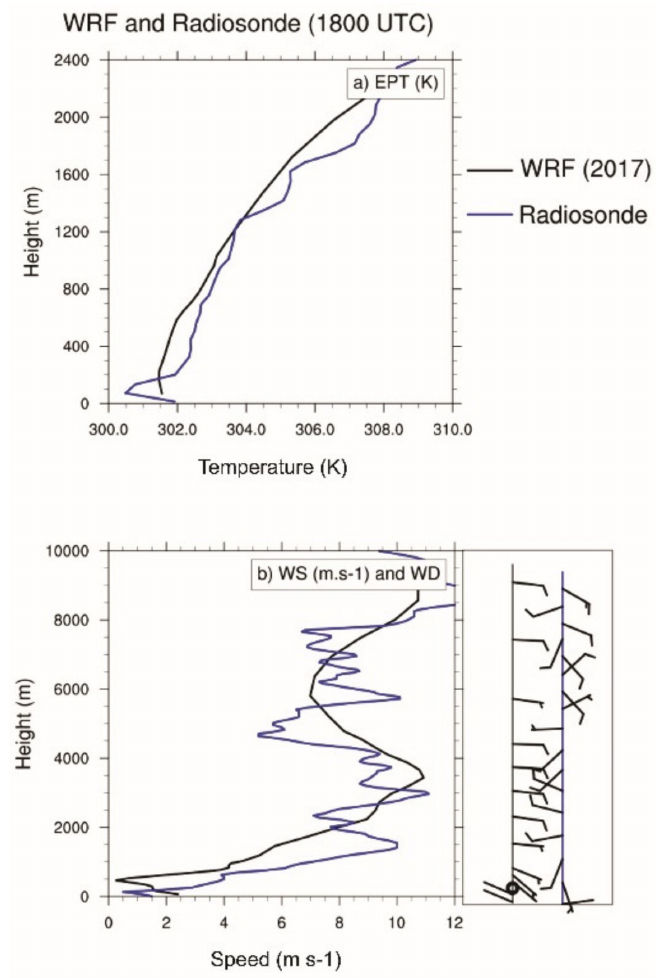
Figure 5. WRF (black) and radiosonde (blue) vertical profiles at 1800 UTC of the equivalent potential temperature (K) ( a ) and the wind speed (WS) and direction (WD) ( b